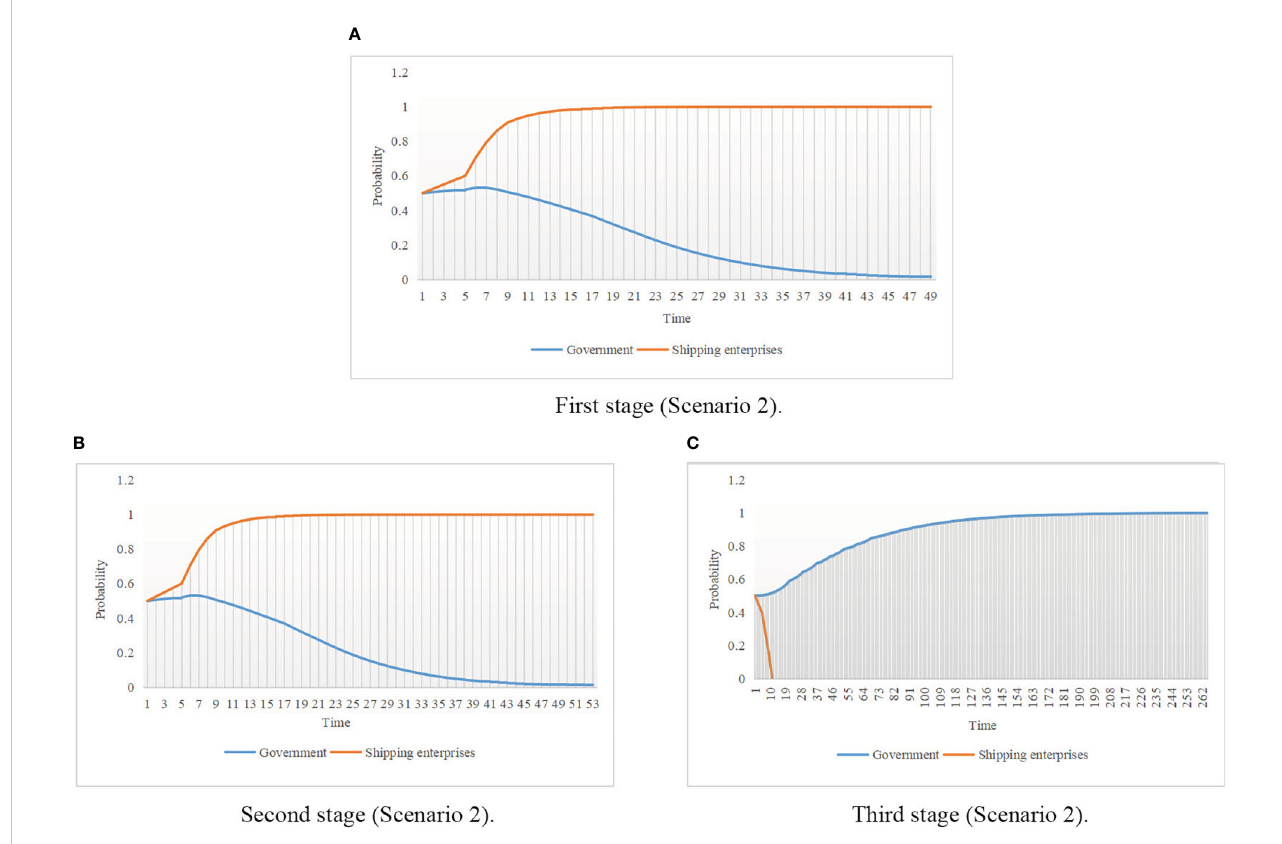
FIGURE 6 Evolutionary path of both sides (Scenario